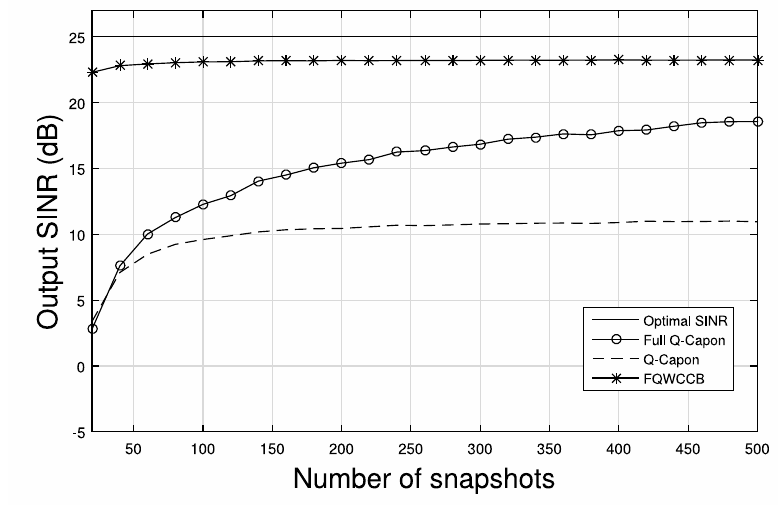
Figure 8. Output SINR versus snapshot number with SNR = SIR = 15 dB and 1 ◦ error.